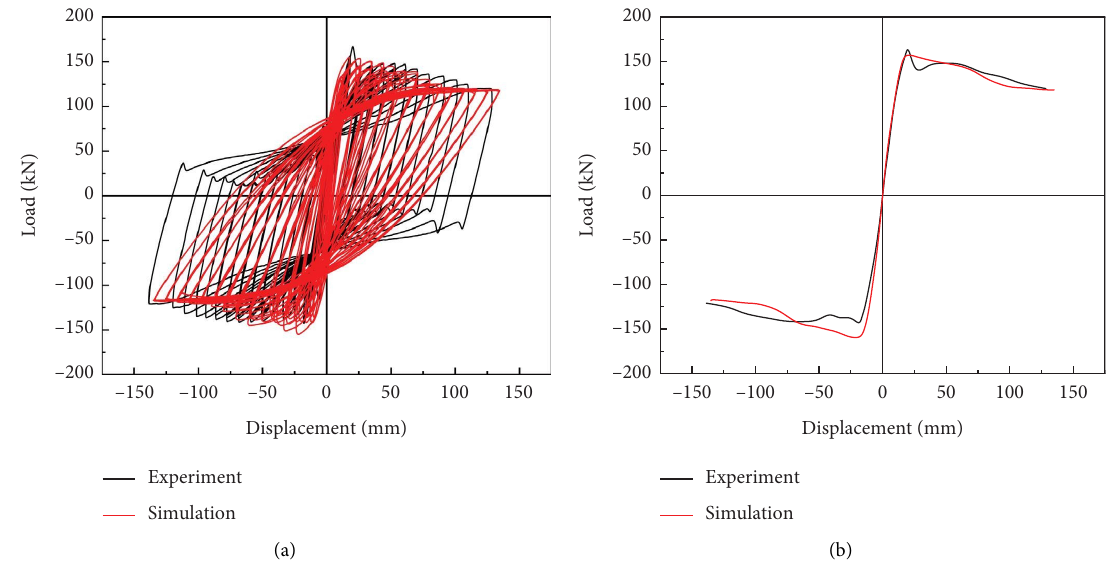
Figure 10: /e comparison between experimental results and simulation results. (a) Hysteretic curves. (b) Skeleton